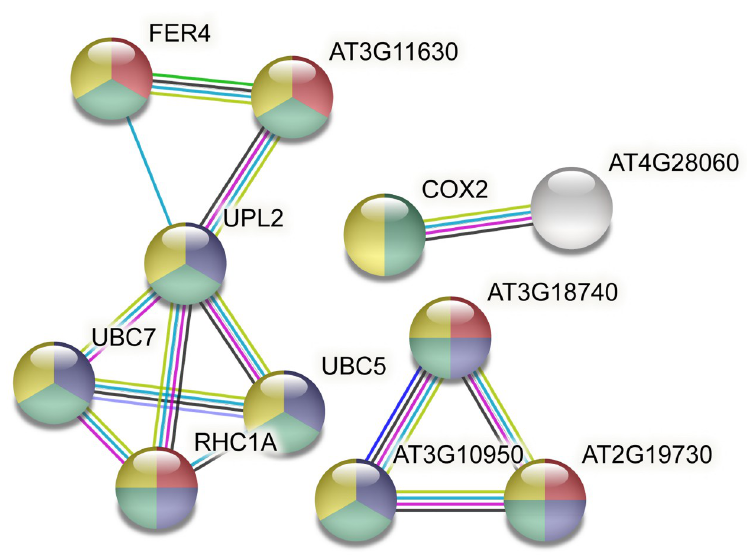
Fig 12. The protein-protein interactions of hub proteins. Response to the stimulus (GO:0050896), cellular macromolecule metabolic process (GO:0044260), metabolic process (GO:0008152), and cellular process (GO:0009987) are respectively shown in red, blue, green, and